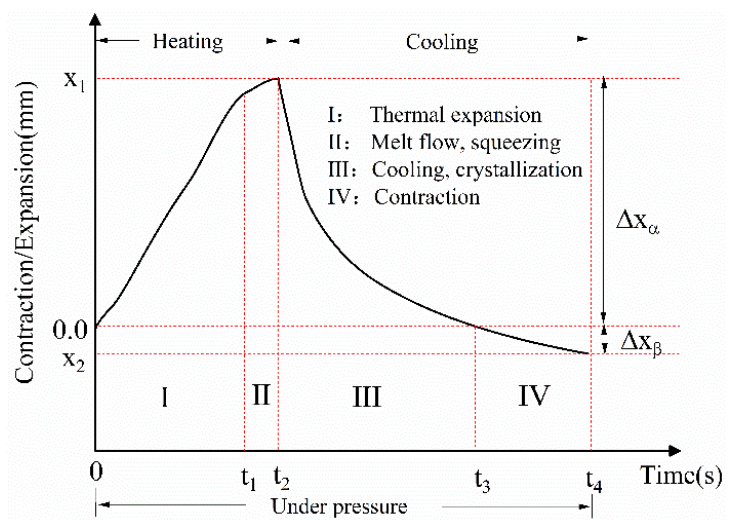
Figure 4. Typical displacement variation in CF/PEEK laminate resistance welding. ΔX α : maximum expansion displacement, ΔX β : final contraction displacement.